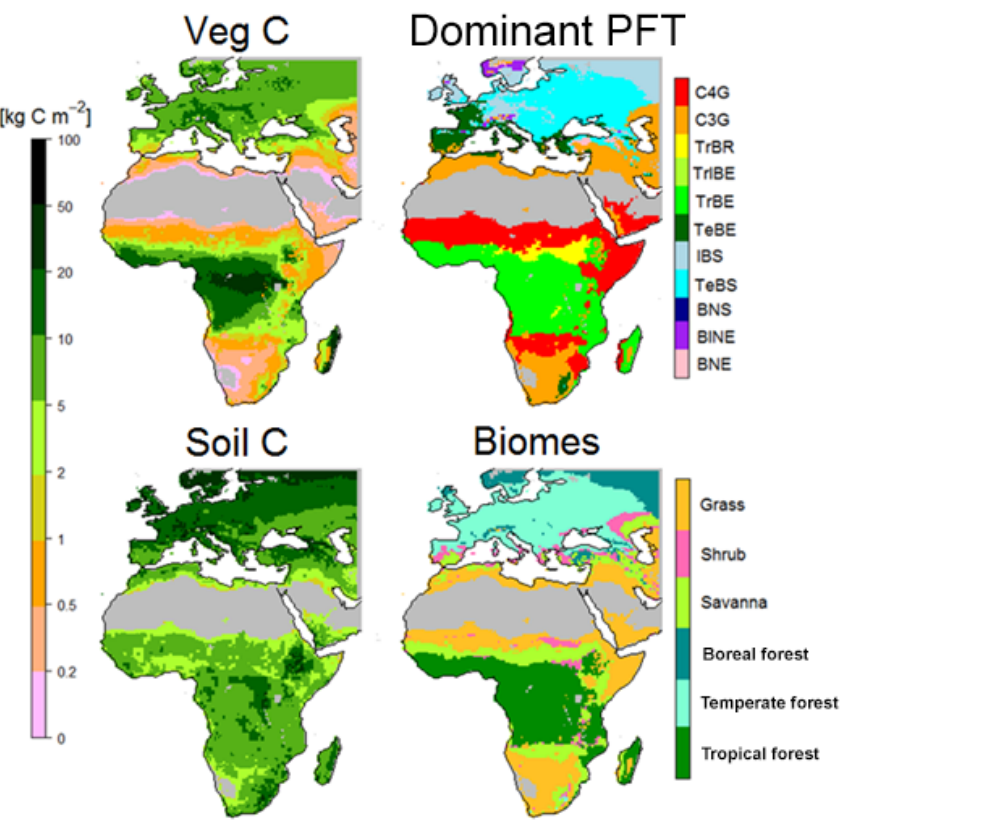
Figure 1. Vegetation C (kgCm − 2 ) for the reference simulation, averaged over the whole simulation period of 900 years (upper left panel), soil C (kgCm − 2 ) (lower left panel), dominant PFT (upper right panel), and corresponding biomes (lower right panel). Grid cells with a NPP below 0.1kgCm − 2 yr − 1 , deserts and tundra, and latitudes above 62.5 ◦ N are masked in grey. PFT abbreviations are given in Table